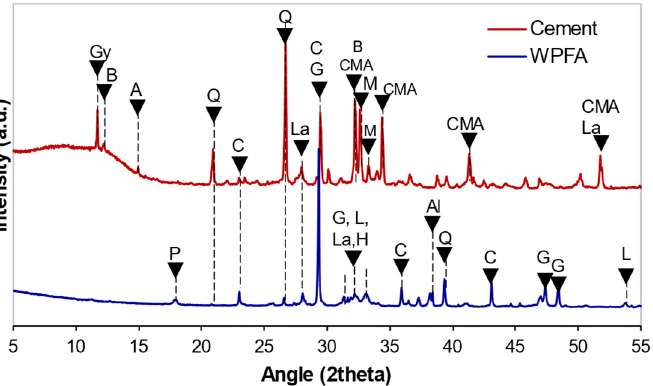
Figure 4. Diffractograms of WPFA and cement. Gy: gypsum, B: brownmillerite, A: albite, Q: quartz,